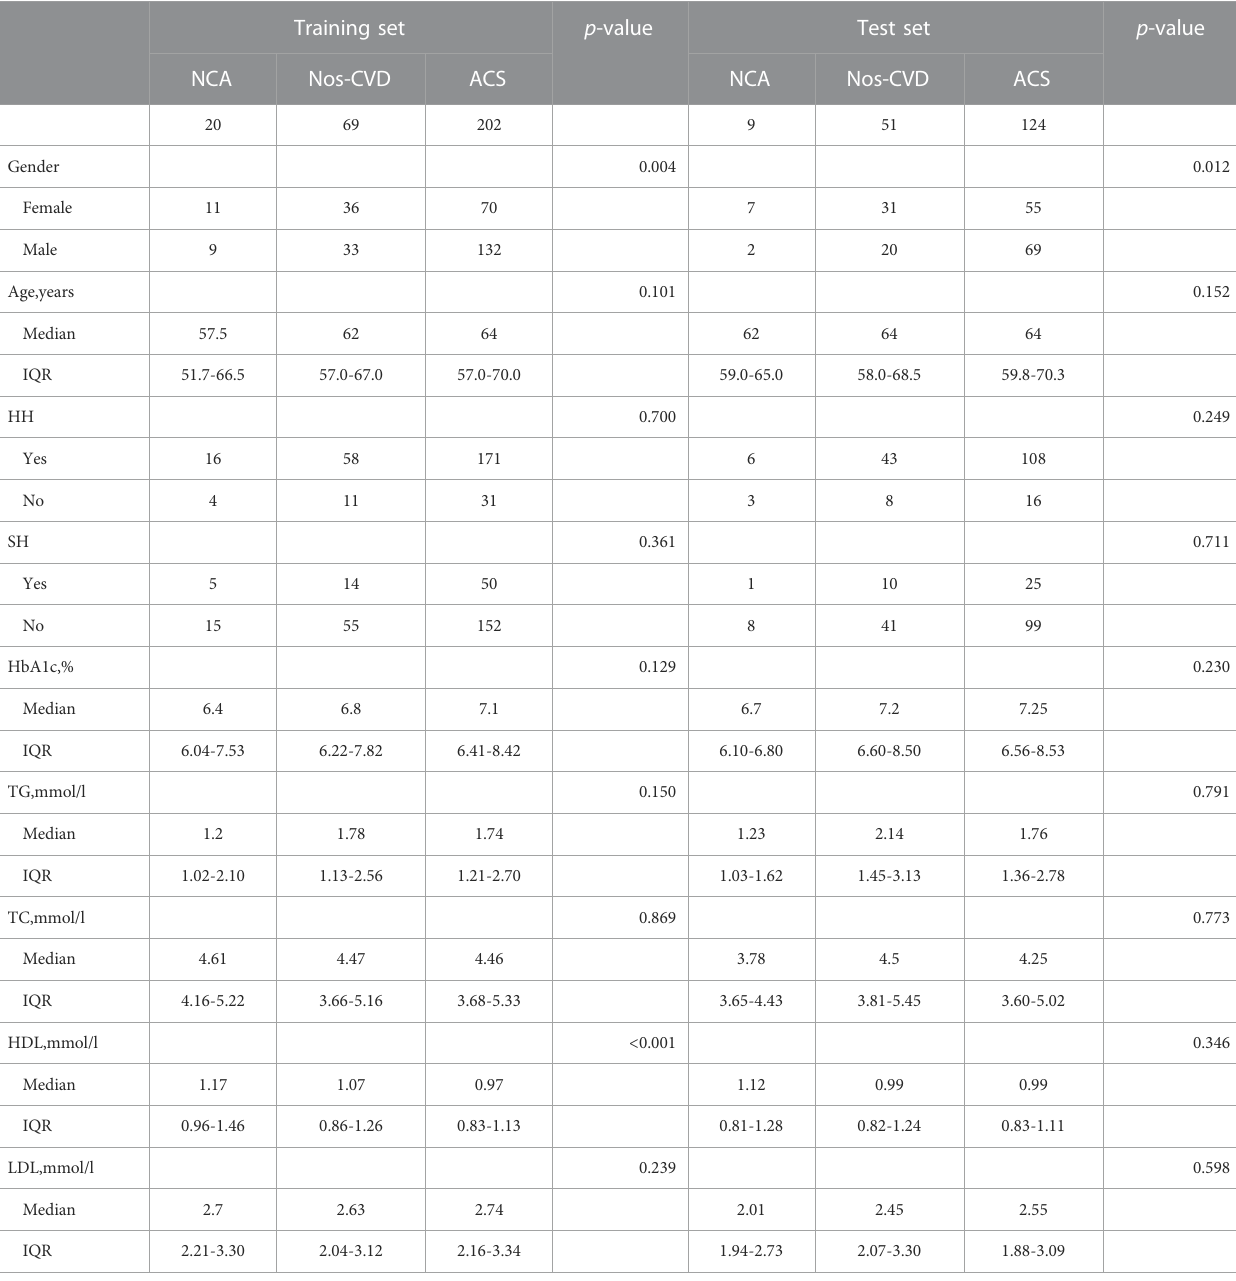
TABLE 1 Basic information in training and test